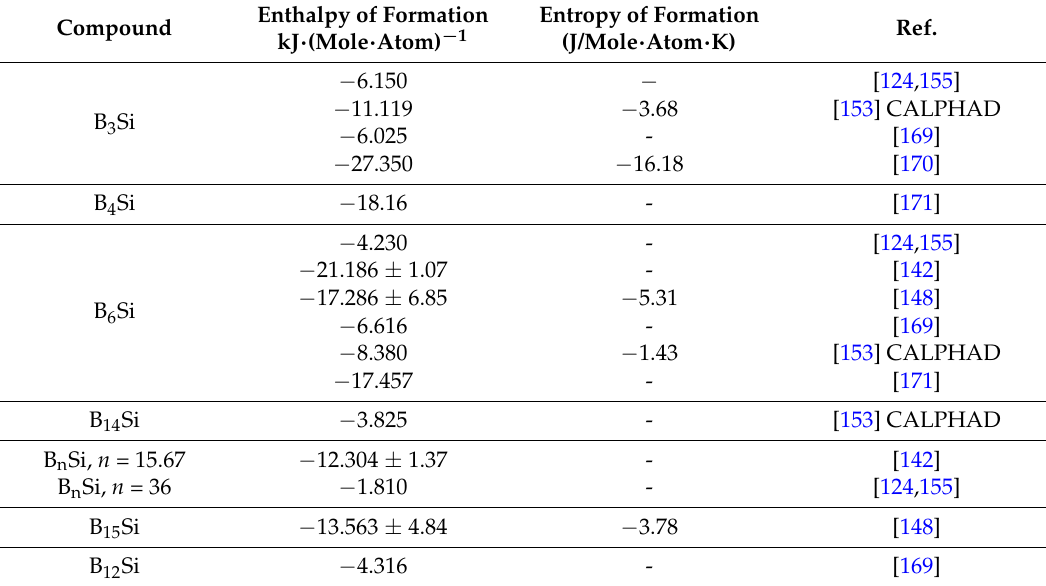
Table 8. The enthalpy and entropy of formation of the B-Si intermetallic compounds. Enthalpy of Compound